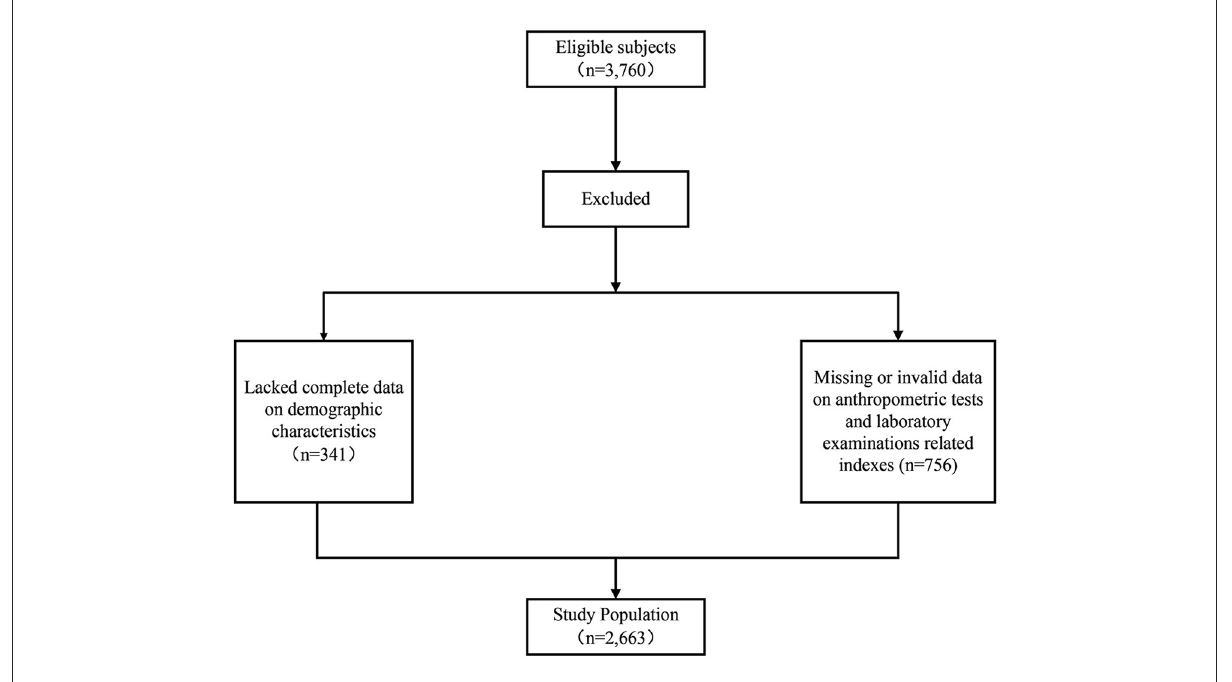
FIGURE1 Flowchart in the selection of study